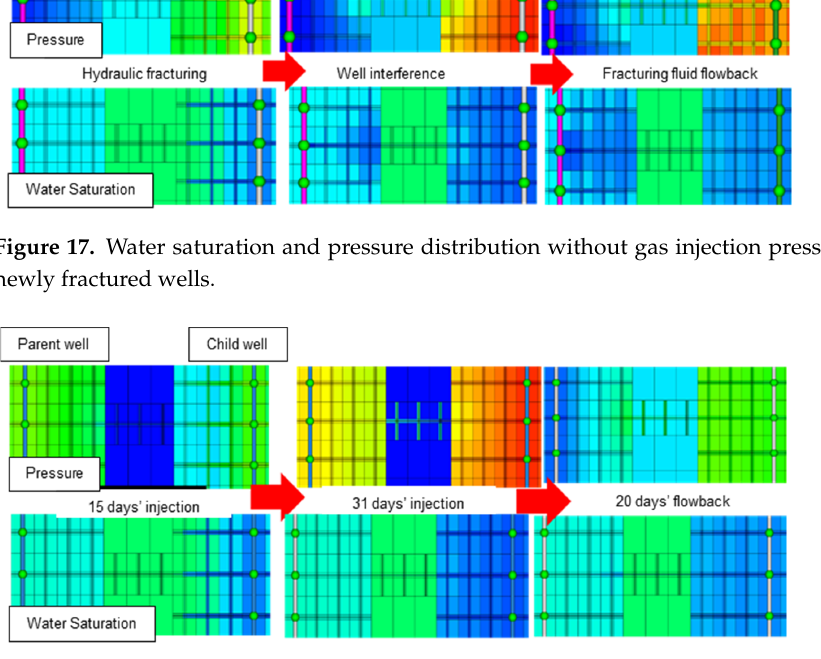
Figure 18. Water saturation and pressure distribution with gas injection pressure boosting of newly fractured wells.